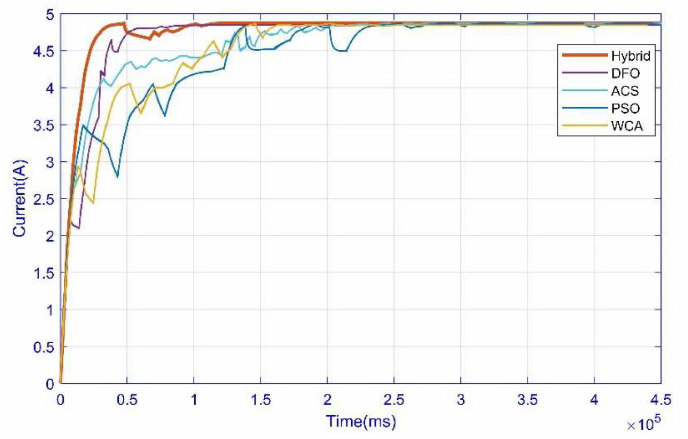
Figure 6. Case 1: Voltage comparison of hybrid with other techniques.